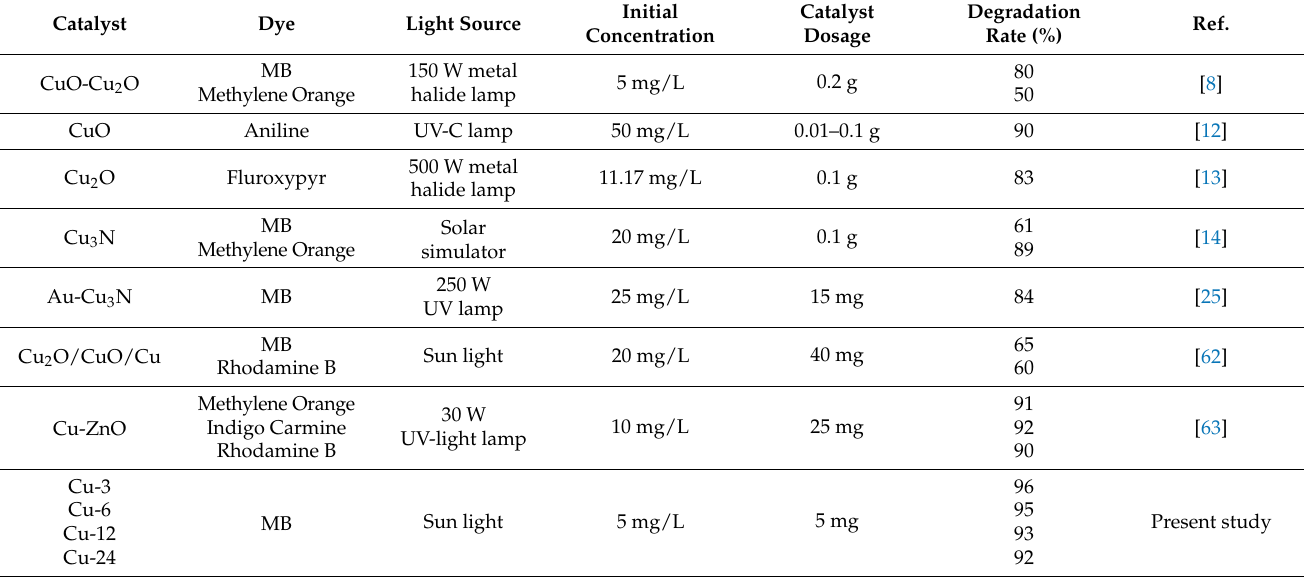
Table 3. Comparison of photocatalytic performance of recent works using Cu-based nanomaterials and the present